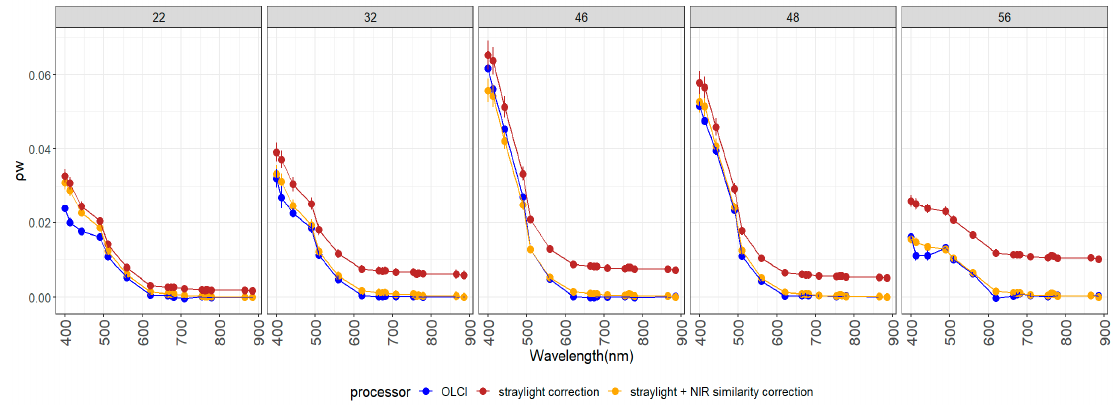
Figure 13. Comparison of OLCI ρ w against TO in situ measured ρ w after straylight correction and after straylight + NIR similarity correction in five match-up stations. The error bars denote respective uncertainties for in situ data and standard deviation inside the Region of Interest (ROI) for OLCI. The general information for each station can be found in Table 1.